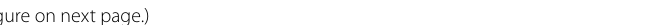
(See figure on next Fig. 2 Repeated dural IS stimulation upregulated P2X7R in the cortical and hippocampal neurons. ( a - b ) Representative immunoblots and quantification illustrated increased levels of P2X7R in the cerebral cortex and hippocampus after repeated dural IS stimulation. ( c - e ) Double immunofluorescence staining showed that P2X7R was co-localized within neurons (NeuN positive) in the cerebral cortex and hippocampus. No substantial colocalization of P2X7R was observed in microglia (Iba-1 positive) and astrocytes (GFAP positive) in the cortex and hippocampus. Magnification 40. Insets show a higher magnification view (Zoom). Scale bar, 20 μm. Images were taken under identical exposures and conditions. × n 6 mice per group. * p < 0.05, ** p < 0.01 and *** p < 0.001 as compared to sham mice. Datasets in (b) were analyzed using Student’s t test. Data are = represented as mean SEM. Abbreviations: IS, inflammatory soup; NeuN, neuronal nuclei; Iba-1, ionized calcium-binding adaptor molecule-1; GFAP, ± glial fibrillary acidic protein